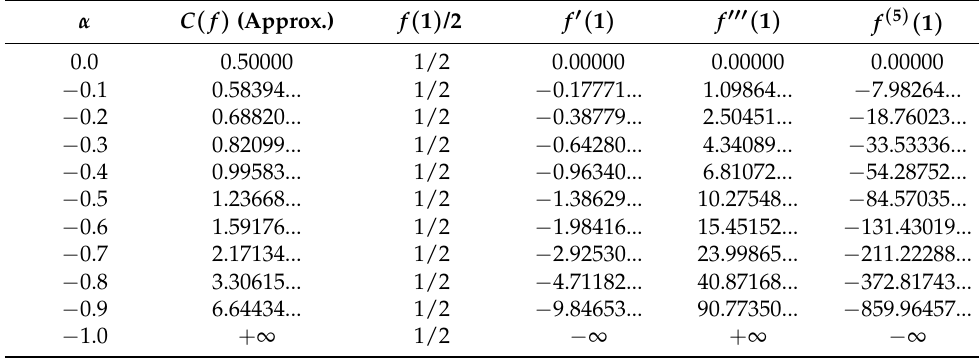
Table 2. Numerical approximations of C (( − 1 ) n − 1 f ) , using Formula (44), evaluated until k = 5, for some values of α < 0